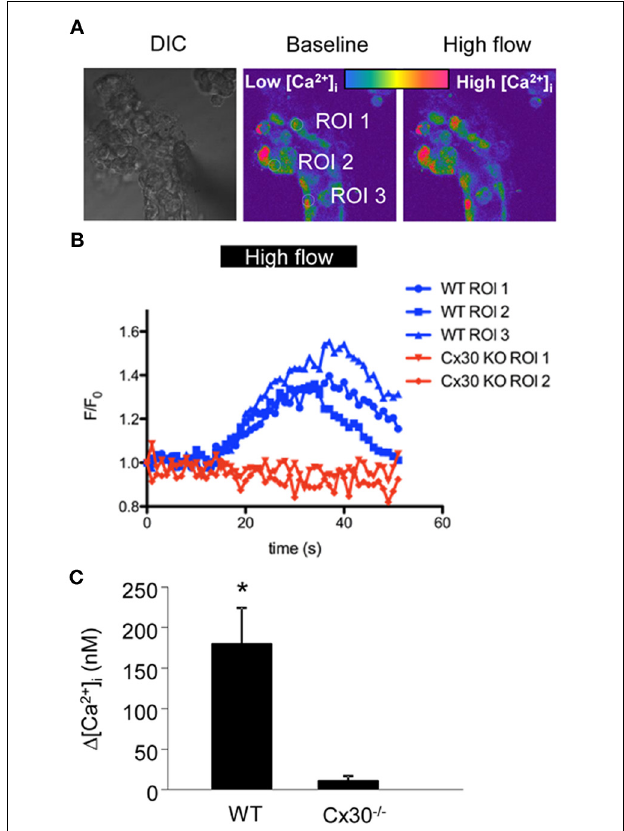
FIGURE 1 | Flow-induced increases in [Ca 2 + ] i in cells of the in vitro microperfused collecting duct. (A) CCDs from wild type and Cx30 − / − mice were freshly dissected and microperfused in vitro , and loaded with the Ca 2 + -sensitive fluorophore pair Fluo-4 and Fura Red. Left: DIC image of a representative preparation. Middle, and right: Pseudo-colored confocal Fluo-4/Fura Red ratio images of the same CCD before and after increasing tubular flow from low (2nl/min) to high (20nl/min) rates. (B) Representative recordings of Fluo-4/Fura Red ratio from 3 ROIs from wild type (blue, as shown in panel A ) and 2 ROIs from Cx30 − / − CCDs (red) show that Cx30 is essential for flow-induced increases in [Ca 2 + ] i . (C) Summary of the CCD [Ca 2 + ] i responses illustrates that the increase in [Ca 2 + ] i in response to high flow was almost completely abolished in Cx30 − / − mice. ( ∗ p < 0 . 001, n = 10 wild-type and 8 Cx30 − / − ).